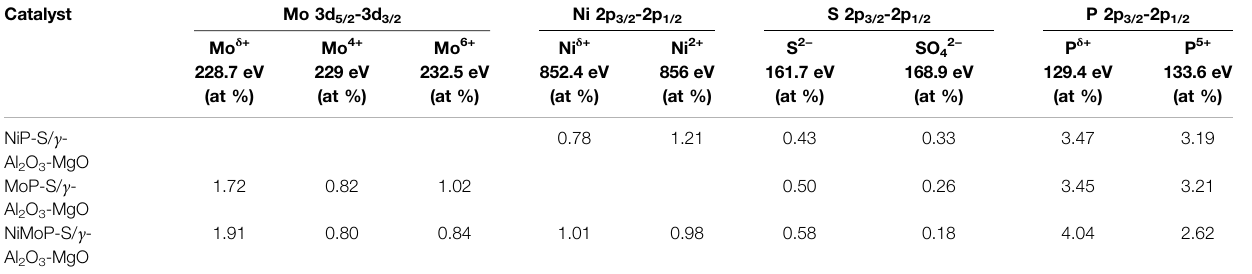
TABLE 3 | Atomic chemical composition of the Mo 3d, Ni 2p, P 2p, and S 2p regions in the Al 2 O 3 -MgO supported NiMo mixed phosphidic-sulphidic phase.